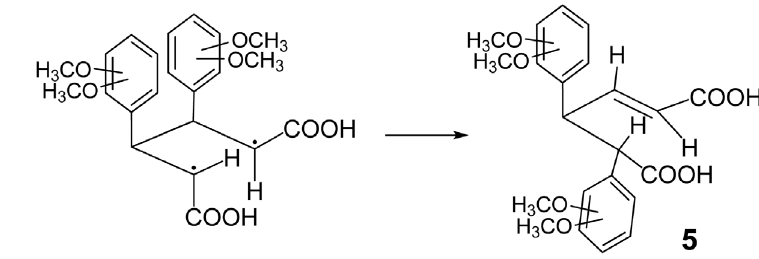
Scheme 2. The formation of dimeric product 5 from a biradical